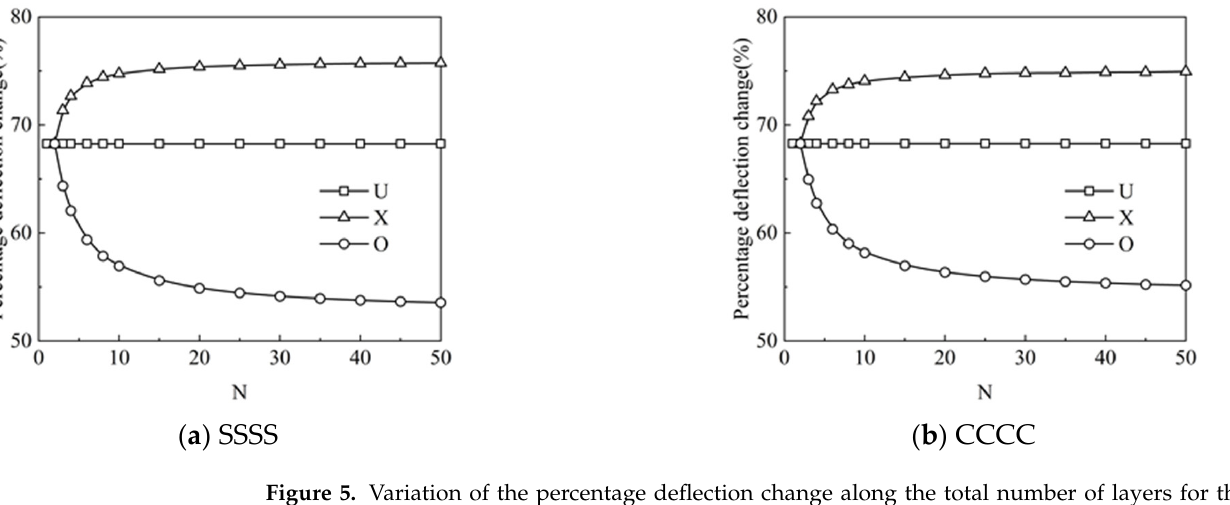
Figure 5. Variation of the percentage deflection change along the total number of layers for the ( a ) SSSS and ( b ) CCCC FG-GRP plates.